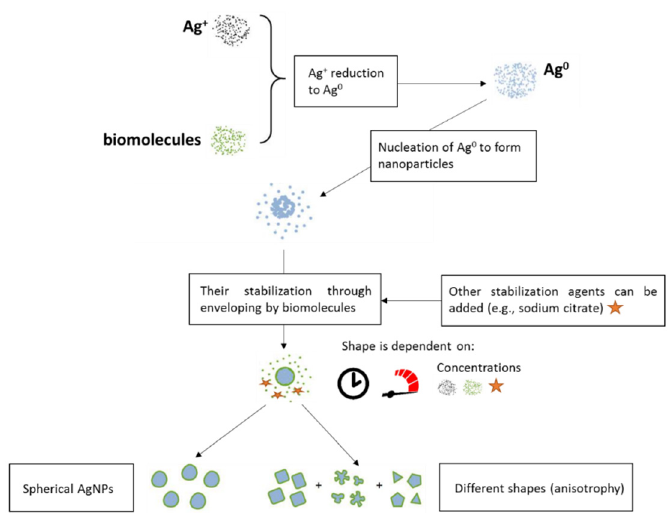
Figure 8. A model example of green synthesis of AgNPs. As mentioned in Figure 7, the green synthesis of AgNPs is based on using extracts from plants or fungi, which contain a giant spectrum of di ff erent oxidative and reductive agents. These molecules reduce silver ions (Ag + ) to elementary silver (Ag 0 ). Compounds which influence the reduction and capping of originating AgNPs are, for example, proteins, alkaloids or polysaccharides. Di ff erent types of nanoparticles can be prepared depending on reaction conditions (metal concentration, extract concentration, length of synthesis, stabilization agents, etc.).